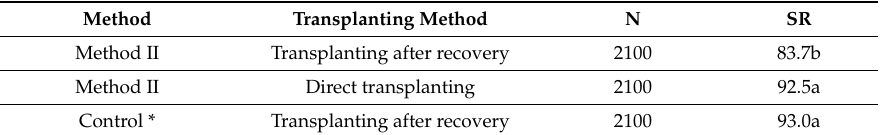
Table 4. Comparison of survival rates of treated seedlings from Method II involving di ff erent transplanting methods in the field.